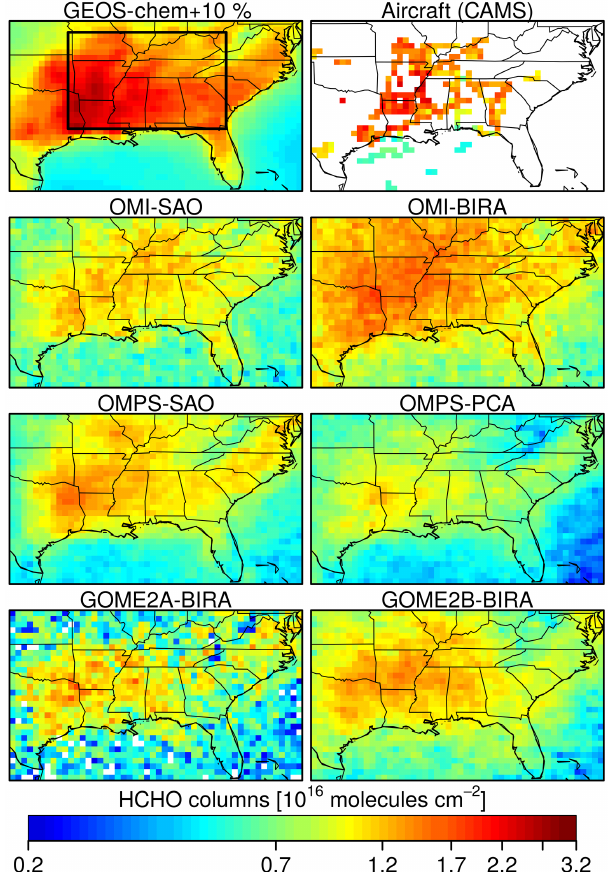
Figure 5. HCHO vertical column densities over the southeast US averaged over the SEAC 4 RS period (5 August–25 Septem- ber 2013). The bottom panels show six retrievals from four satellites (OMI, GOME2A, GOME2B and OMPS) and three different groups (Table 1). The top panels show (1) GEOS-Chem model results sam- pled on the OMI schedule with filtering by OMI-SAO quality flags and cloud conditions, and increased by 10% to correct for the bias relative to CAMS aircraft measurements, and (2) columns derived from the CAMS aircraft measurements (same as bottom left panel of Fig. 1 but on a different color scale). The black rectangle repre- sents the southeast US domain (same as in Fig. 1). Color bar is a logarithmic